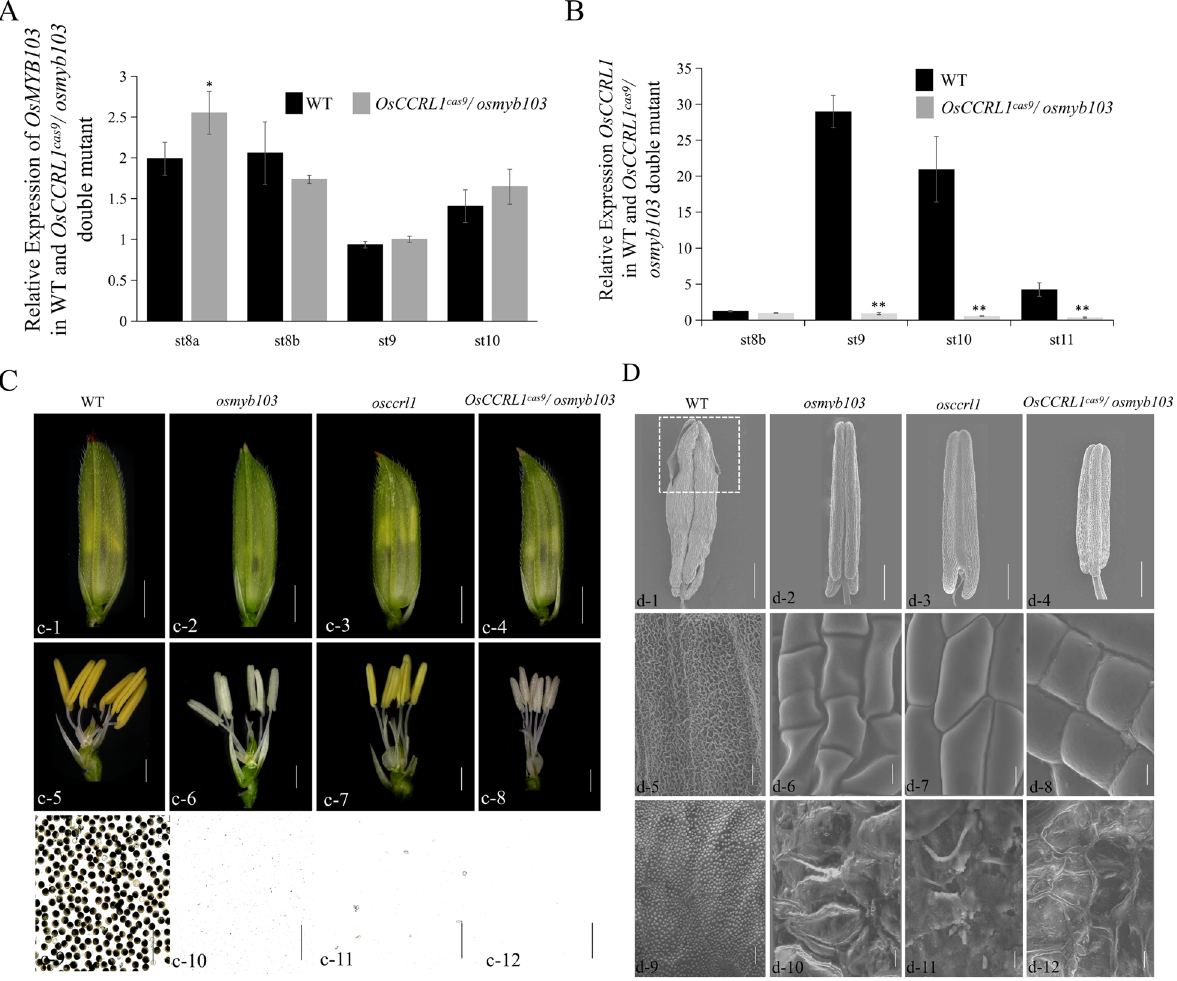
Fig. 7 Phenotypic analysis of osmyb103 osccrl1 double mutant transgenic plants. A , B The relative expression comparison of OsMYB103 and OsCCRL1 between the wild-type and osmyb103 osccrl1 double mutant anthers. Data are means differences determined by Student’s t-test (*,